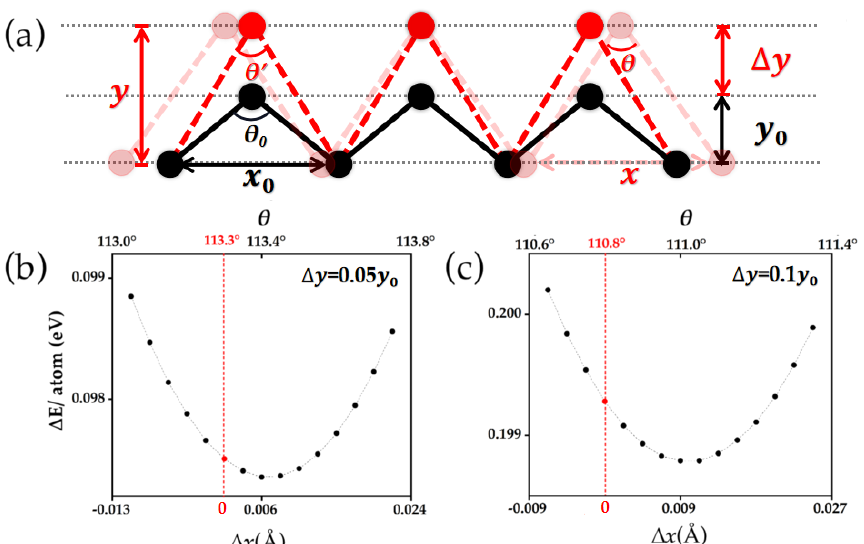
Figure 2. ( a ) A schematic view of a zigzag chain under a tensile strain. The black dots represent an intrinsic zigzag chain without strain, determined by structure parameters θ 0 , x 0 and y 0 . The light red dots represent the final chain under a tensile strain along y − axis, where structure parameters change from y 0 to y and θ 0 to θ . Here, the red dots correspond to the case that y 0 changes into y and ∆ x = 0. ( b , c ) The change of energy (per carbon atom) for the zigzag chain as a function of ∆ x = x (cid:48) − x ∆ y = 0.05 y ∆ y = 0.1 y 0 is shown in ( b , c ) with tensile strain 0 ( b ) and 0 ( c ), separately. Following Equation (1), the variation of angle θ corresponds to the variation of ∆ x